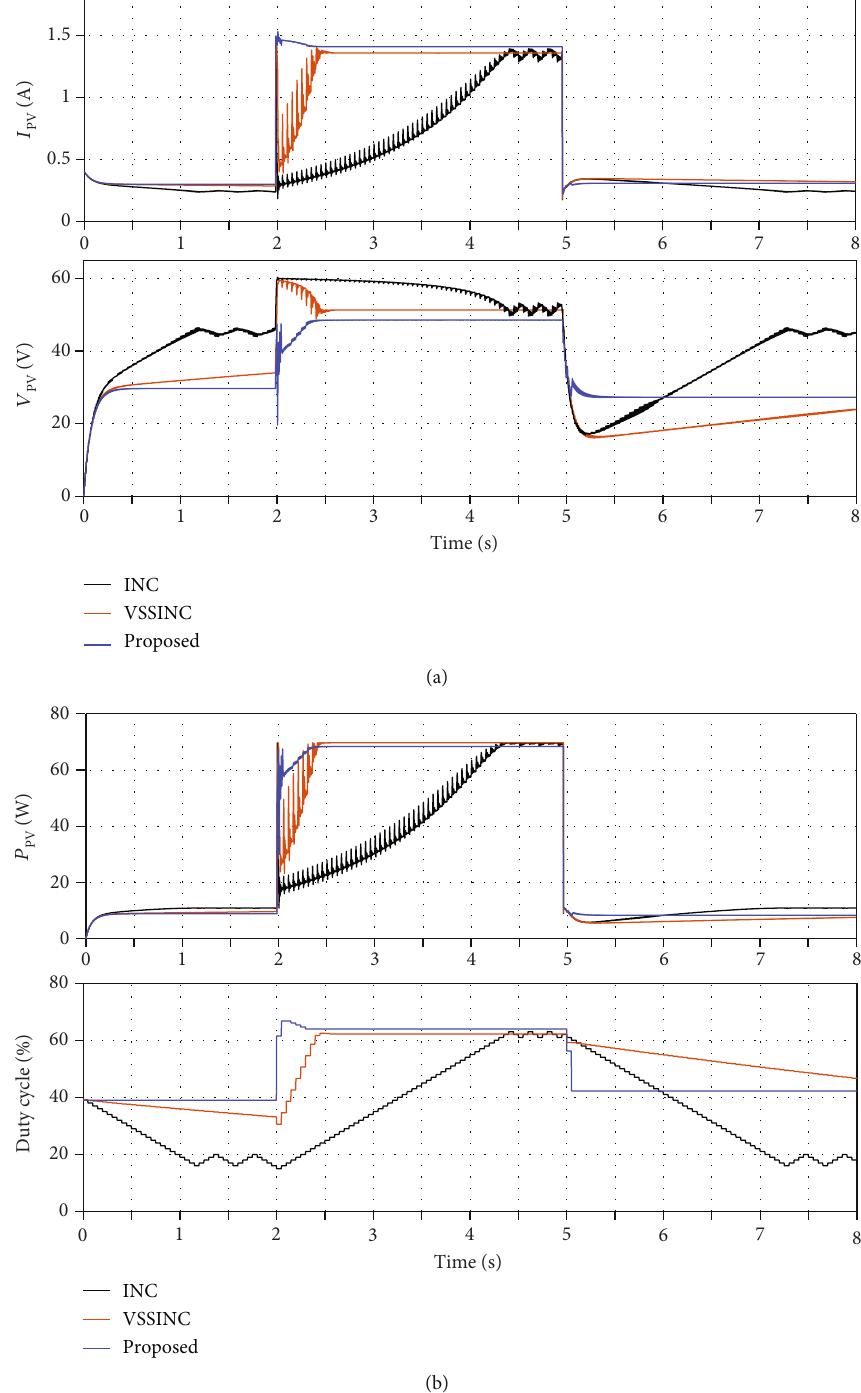
Figure 10: Simulation results of the INC, VSSINC, MINC, and the proposed technique for the irradiance variation under weak intensity: (a) current and voltage; (b) power and duty